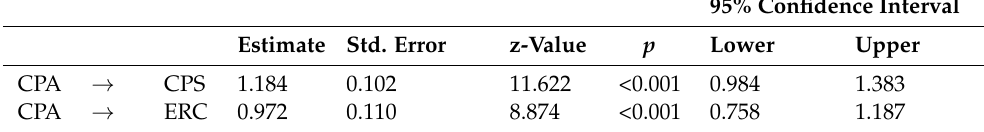
Table 4. Direct effects.